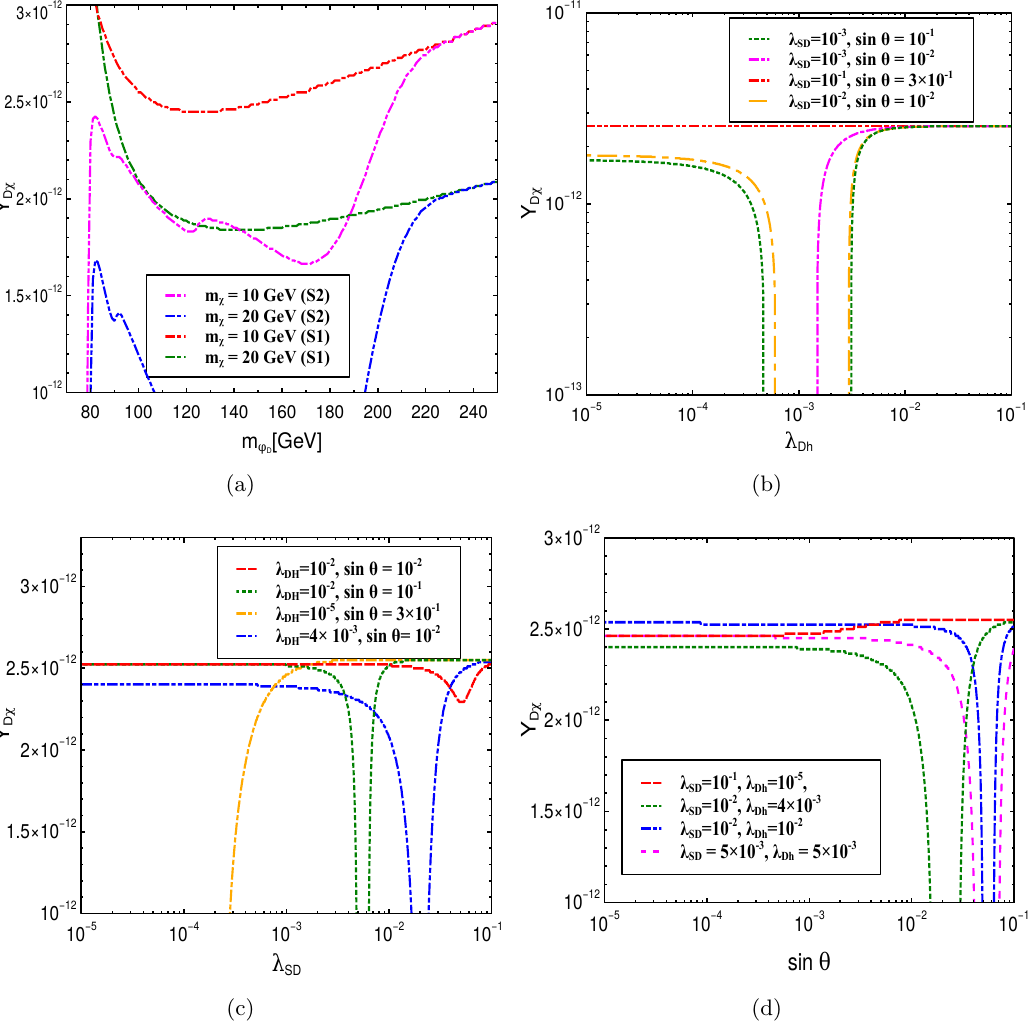
= 0 . 12 in the coupling Y and mass of φ Dχ D χ and λ plane, figure 12(c) and figure 12(d) Dχ Dh - λ , and Y - sin θ plane. The parameter chosen for this plot are as Dχ SD Dχ = 50 GeV, m = 10 GeV, m = 100 GeV, g = 0 . 9 , m = 7 N χ φ D BL Z BL